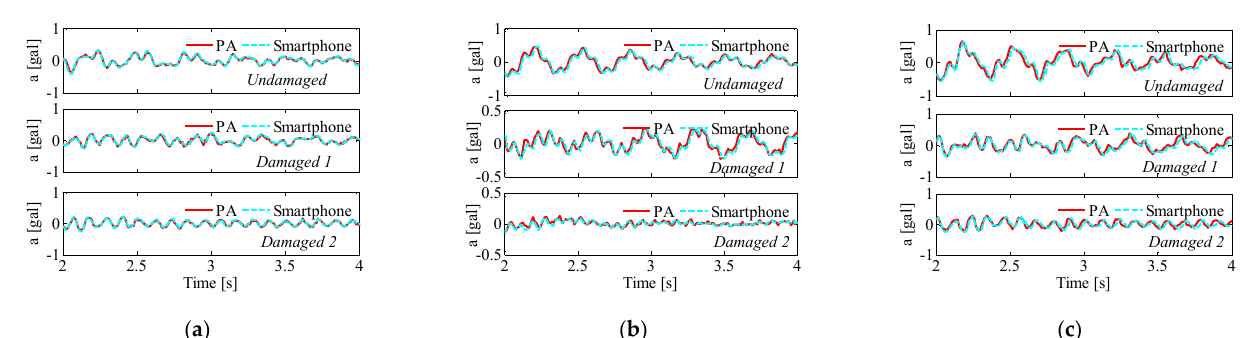
Figure 4. The acceleration time history responses as collected by the tethered PAs and smartphones, for both undamaged and two damaged cases, were compared to show good agreement. Representative results from the ( a ) first, ( b ) second, and ( c ) third floors were overlaid.